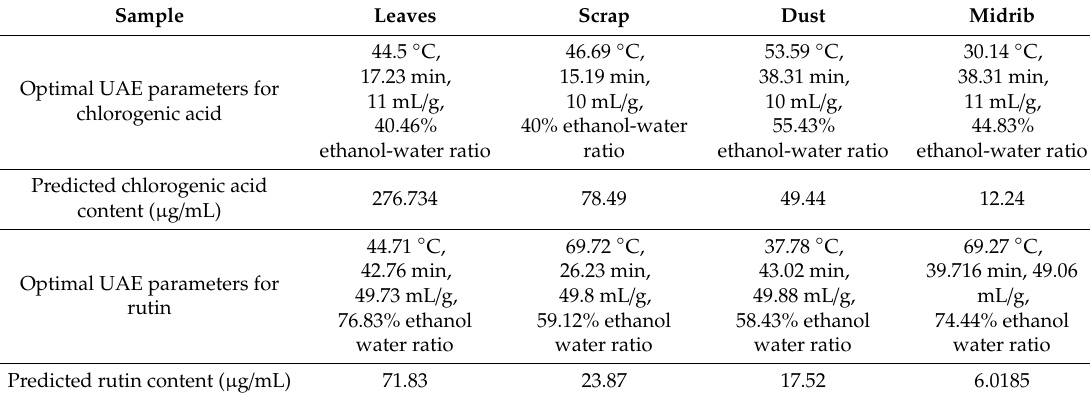
Table 8. Optimal UAE conditions for the extraction of chlorogenic acid and